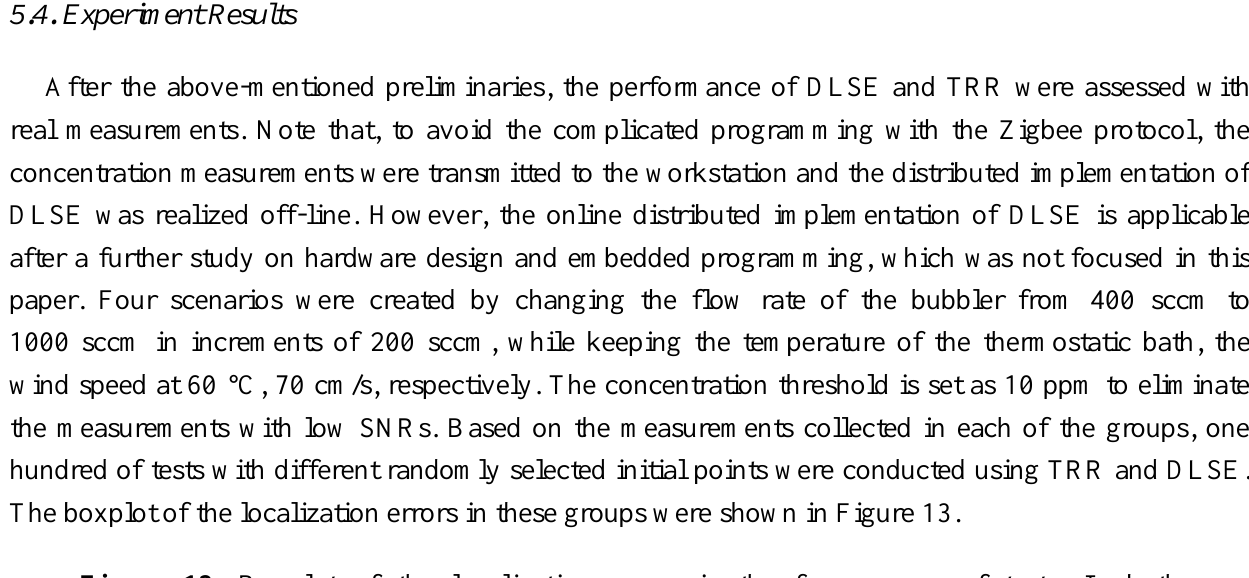
Figure 13. Boxplot of the localization errors in the four groups of tests. In both sub-figures, the maximum whisker lengths of the boxplots are set as 1. ( a ) The localization errors of TRR; ( b ) The localization errors of